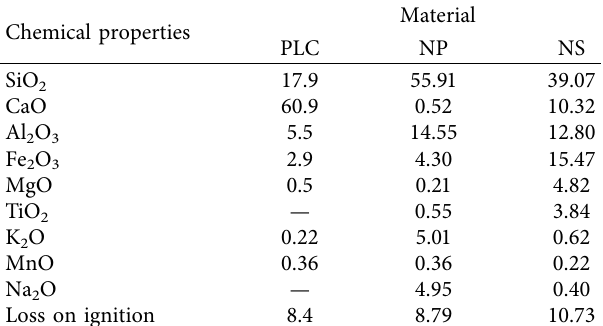
Table 3: Chemical properties of PLC, NP, and NS. Chemical properties